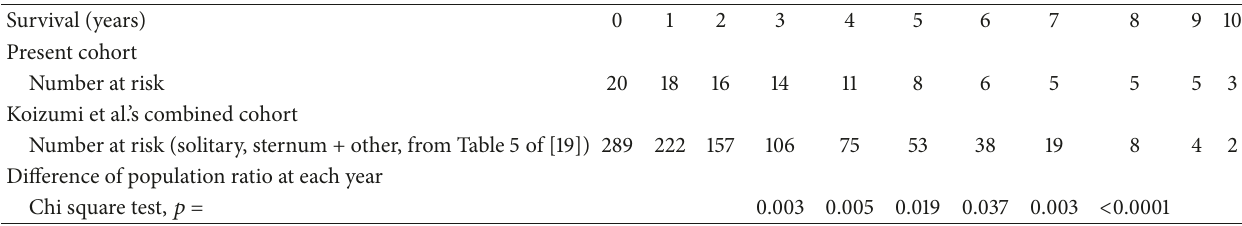
Table 2: Comparison between the present cohort and the historical control, Koizumi et al.’s combined cohort, in Japan. Survival (years)